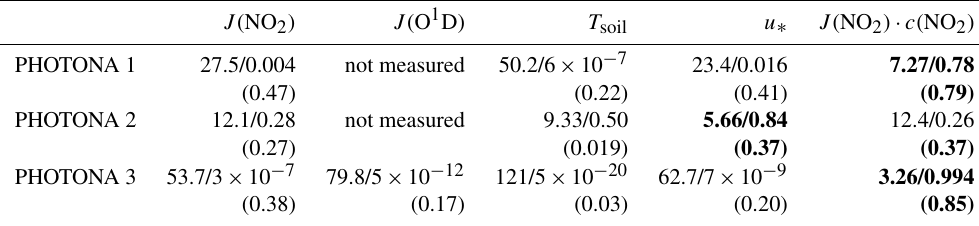
Table 1. Goodness of the weighted orthogonal regressions of hourly average daytime data (06:00 to 20:00UTC) of F (HONO) against different variables for the three PHOTONA campaigns. The numbers represent χ 2 /Q(R 2 ) values for which lower χ 2 and higher Q and R 2 values indicate better correlations (for definition see Brauers and Finlayson-Pitts, 1997). Bold numbers represent the strongest correlations observed for each